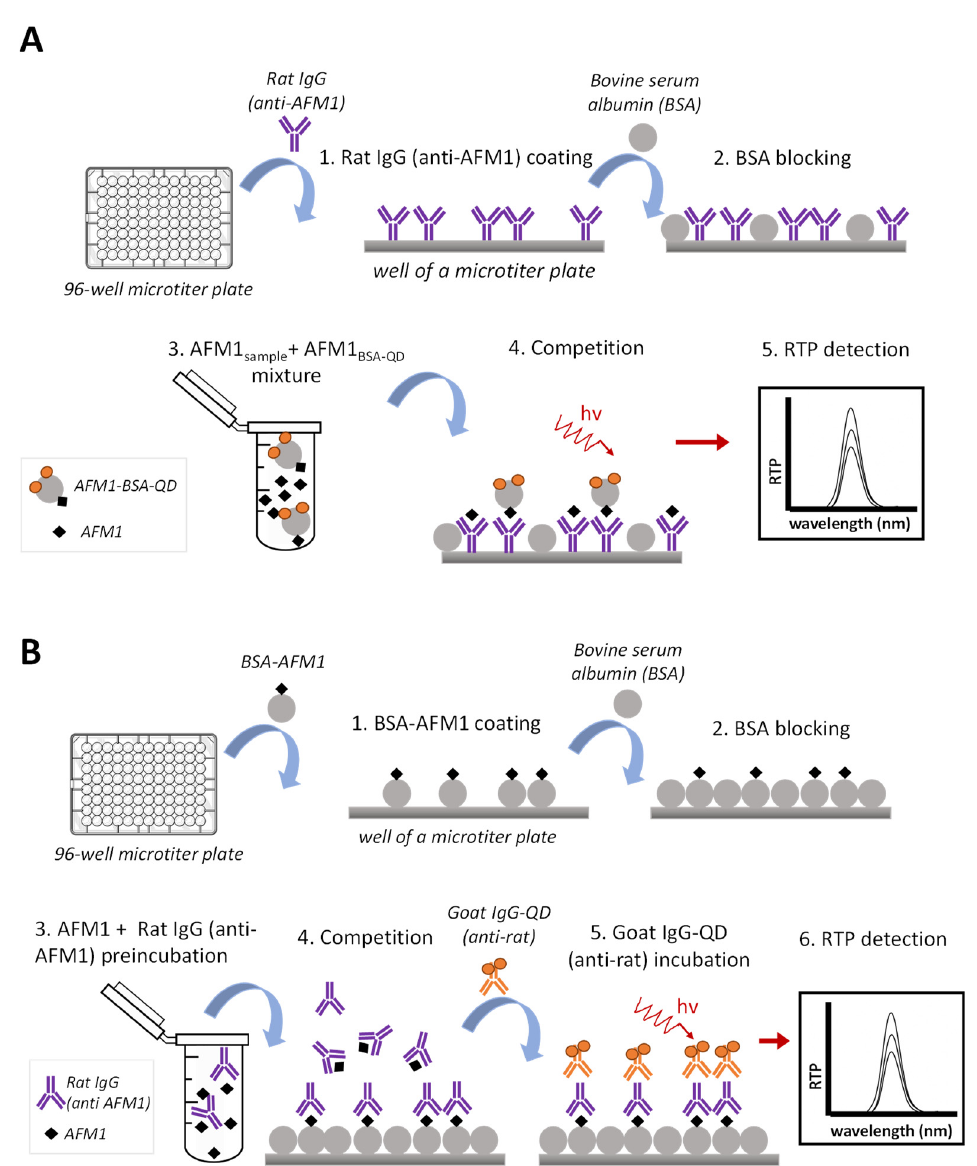
Figure 1. Schematic diagram of the competitive room temperature phosphorescent (RTP) immuno- assays assayed for AFM1 quantification: ( A ) indirect competitive immunoassay; ( B ) direct compet- itive immunoassay.